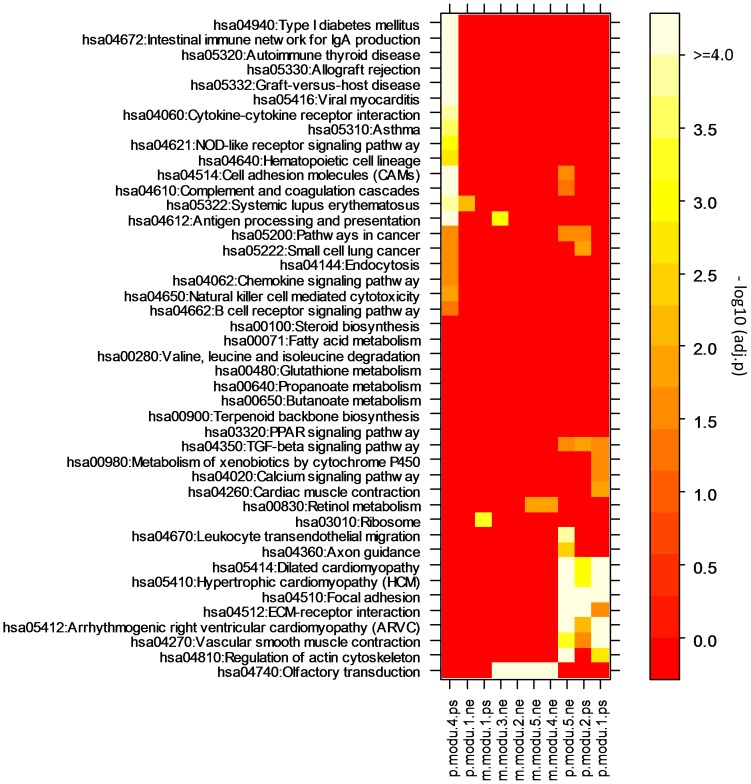
Over-represented KEGG pathways in the individual modular gene sets of 10 major miRNA-mRNA modules discovered for primary prostate cancer (PPC) or metastatic prostate cancer (MPC).The ordinary p-values were adjusted with BH method.